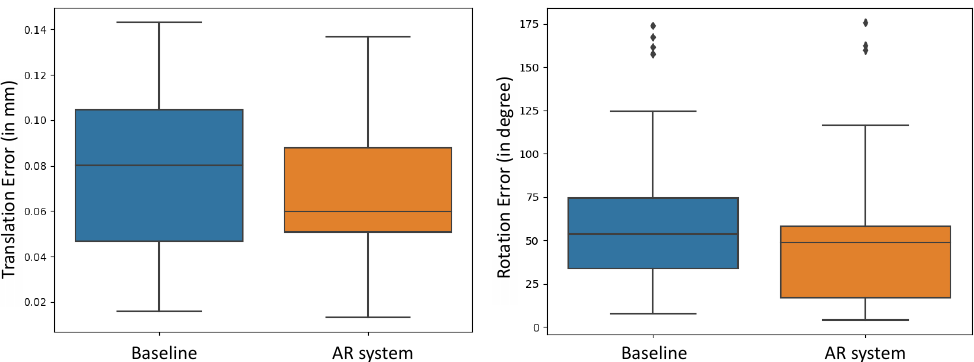
Figure 7. The pose error of the alignment task for both baseline and AR-aided endoscope positioning. We separately evaluated the position and rotation error of the